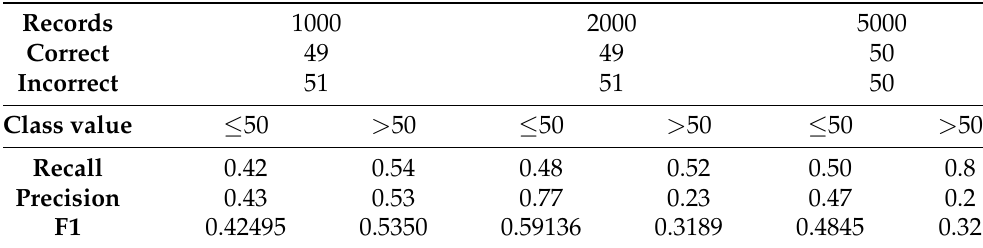
Table 6. Naive Bayes classifier evaluation results.